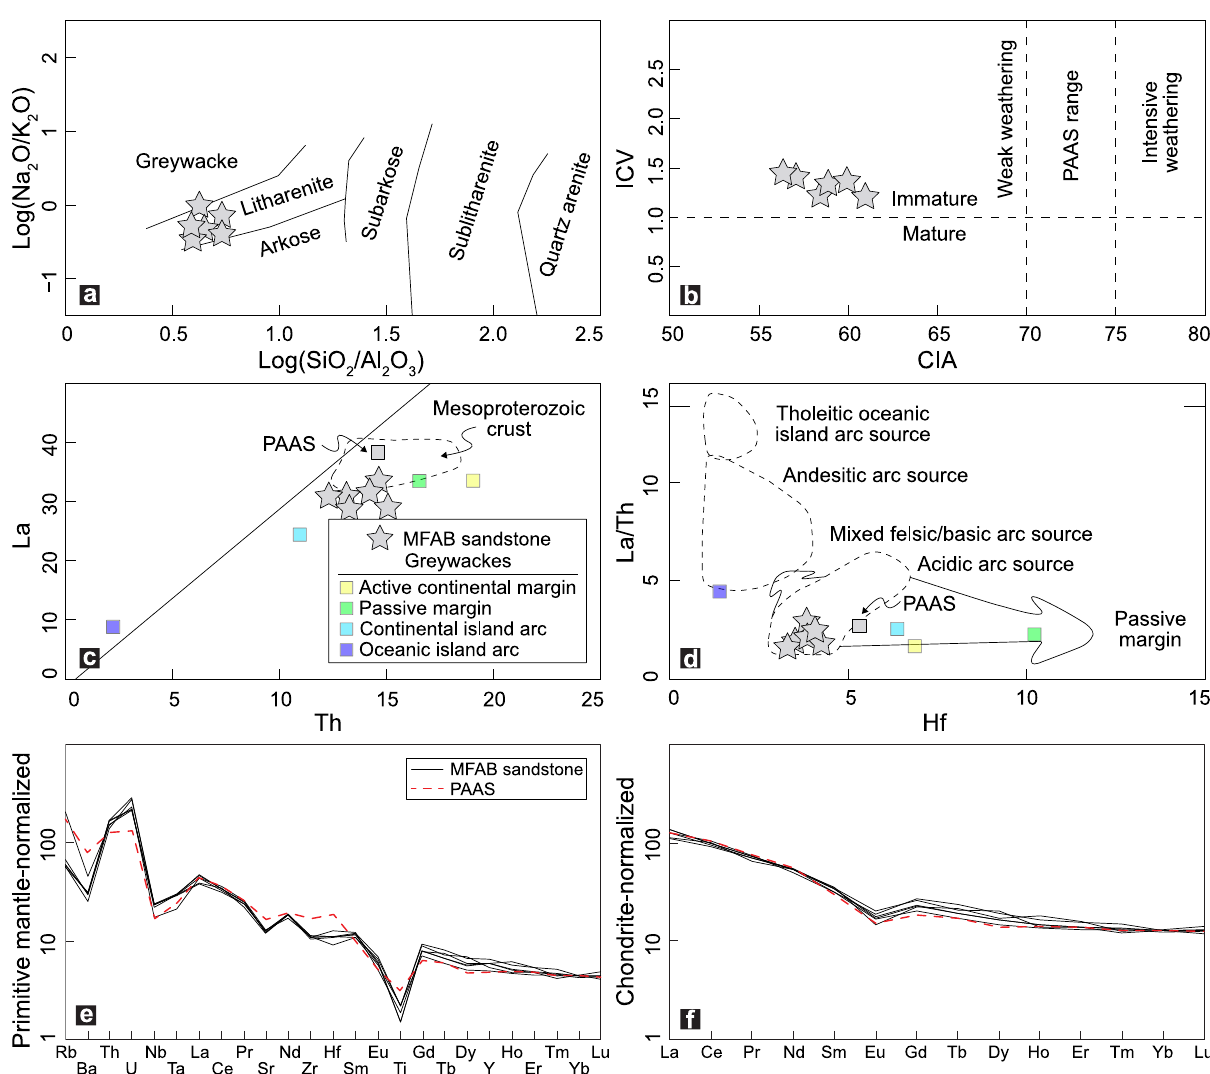
Fig. 3 Geochemical classi fi cation and discrimination of the MFAB sandstones. a log(Na 2 O/K 2 O) vs log(SiO 2 /Al 2 O 3 ) and b ICV vs CIA for studied sandstones; the index of chemical alteration, CIA = [Al 2 O 3 /(Al 2 O 3 + CaO* + Na 2 O + K 2 O)] ×100, where CaO* is the content of CaO in silicate minerals only, is given after ref. 44 and the Index of Compositional Variability, ICV = (CaO + K 2 O + Na 2 O + Fe 2 O3 + MgO + MnO + TiO 2 )/Al 2 O 3 is given after ref. 45 . c La vs Th; d La/Th vs Hf after ref. 130 ; sources: Mesoproterozoic crust. 131 , PAAS 46 , ref. for average graywacke compositions 132 . e , f spider and REEs pattern diagrams of studied sandstones; values of primitive mantle 133 , chondrite 133 , and PAAS 46 are used for normalization and